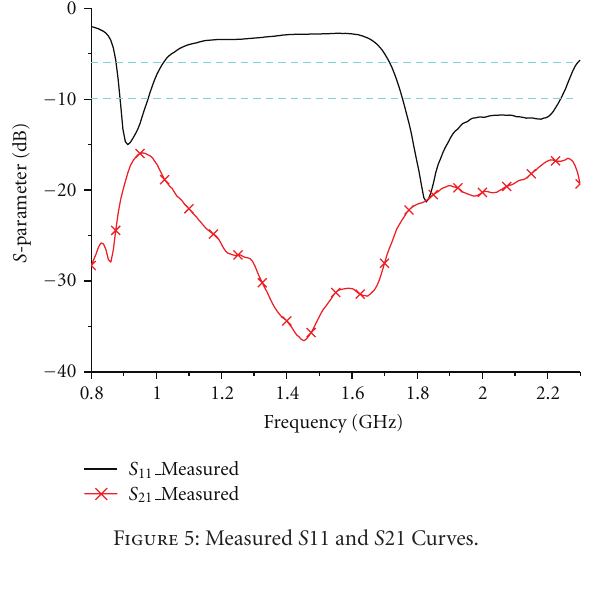
Figure 7: Measured H -Plane radiation pattern of antenna no. 1 at 900 MHz.